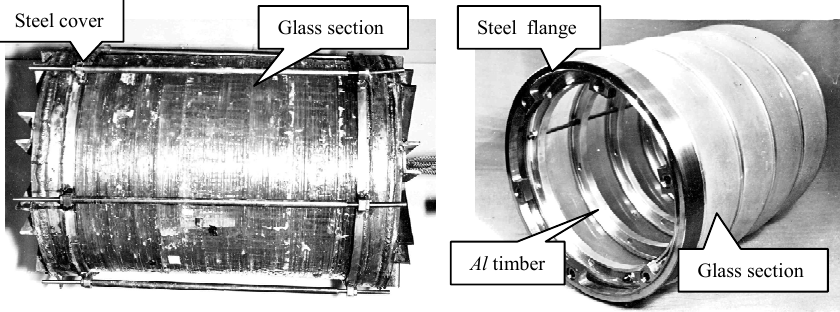
Figure 1. Strong composite glass shells intended for high external